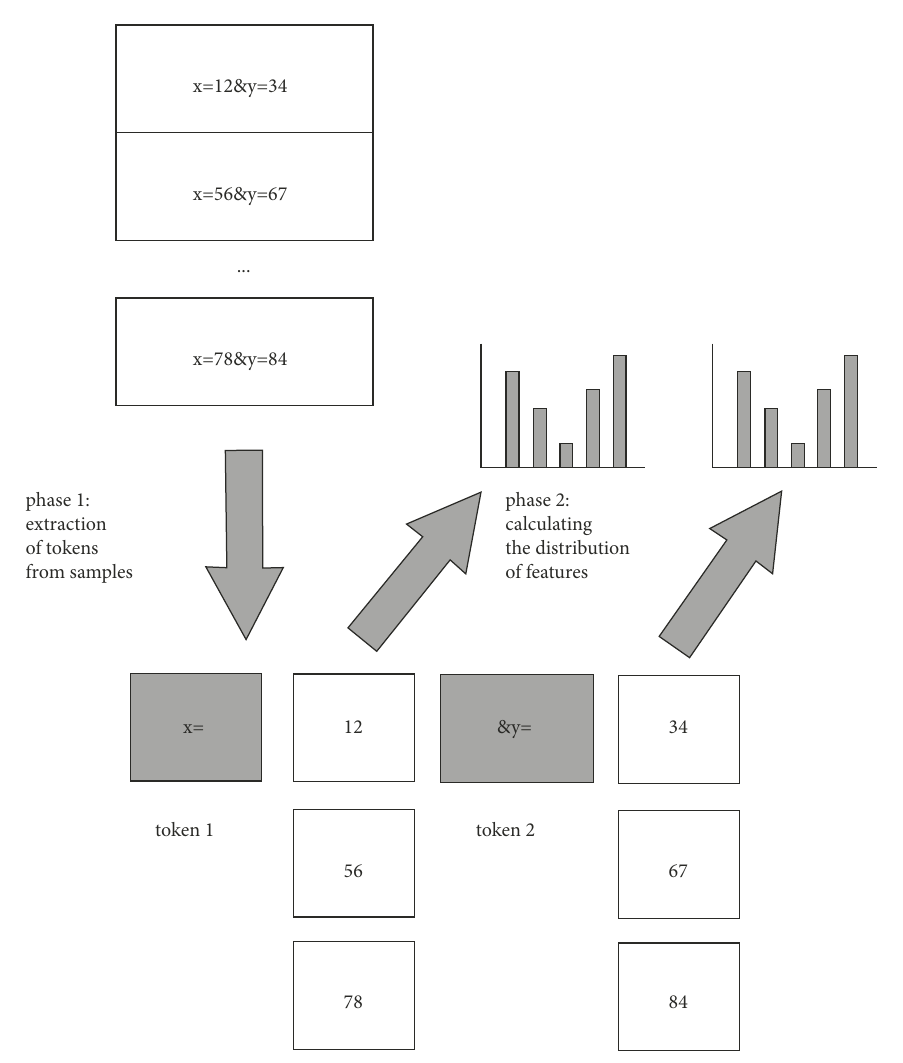
Figure 3: The parameter encoding